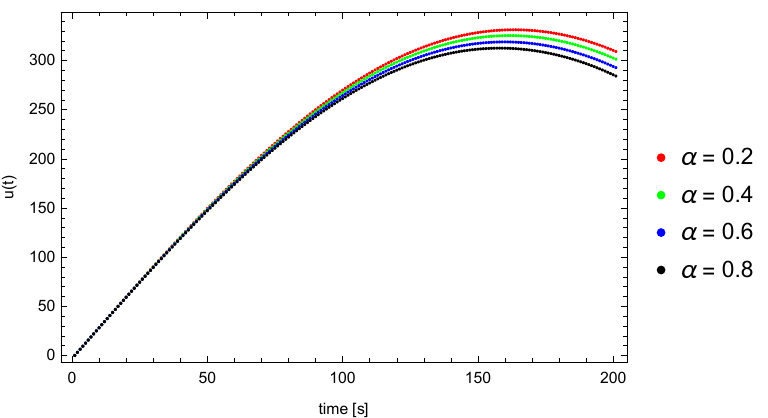
Figure 8. Values of the function u at point K 4 for different values of the parameter α ( β = 0.6, c =